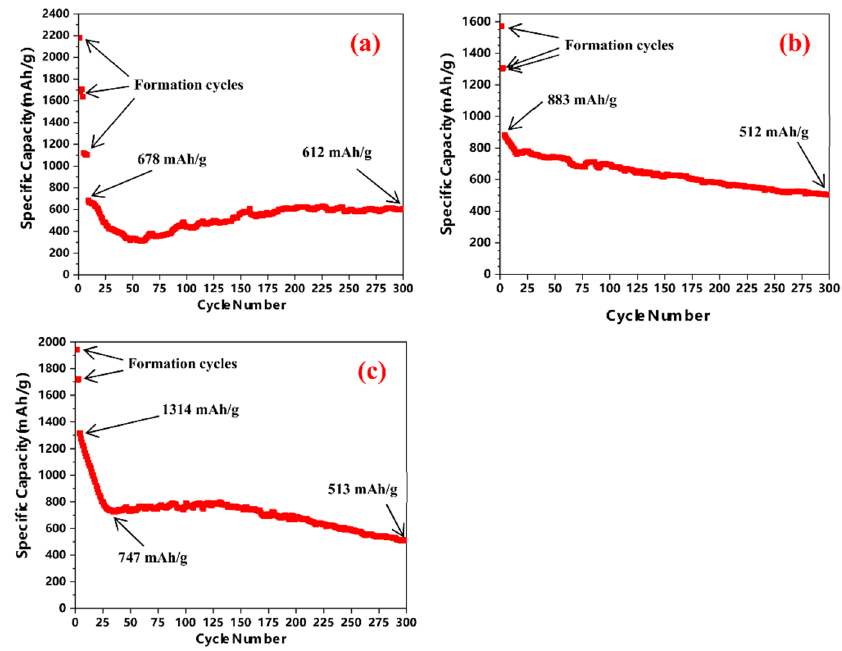
Figure 6. The specific capacity as a function of cycle numbers: ( a ) B1 cell with P2 protocol, ( b ) B2 cell with P3, and ( c ) B3 cell with P1 (see Table 3 for the details of P1, P2 and P3 protocols). All of the electrodes are made of the smallest size group of Si@void@C powder. Further, B1, B2 and B3 cells have the same Si@void@C electrode but with different charge/discharge protocols as indicated above.